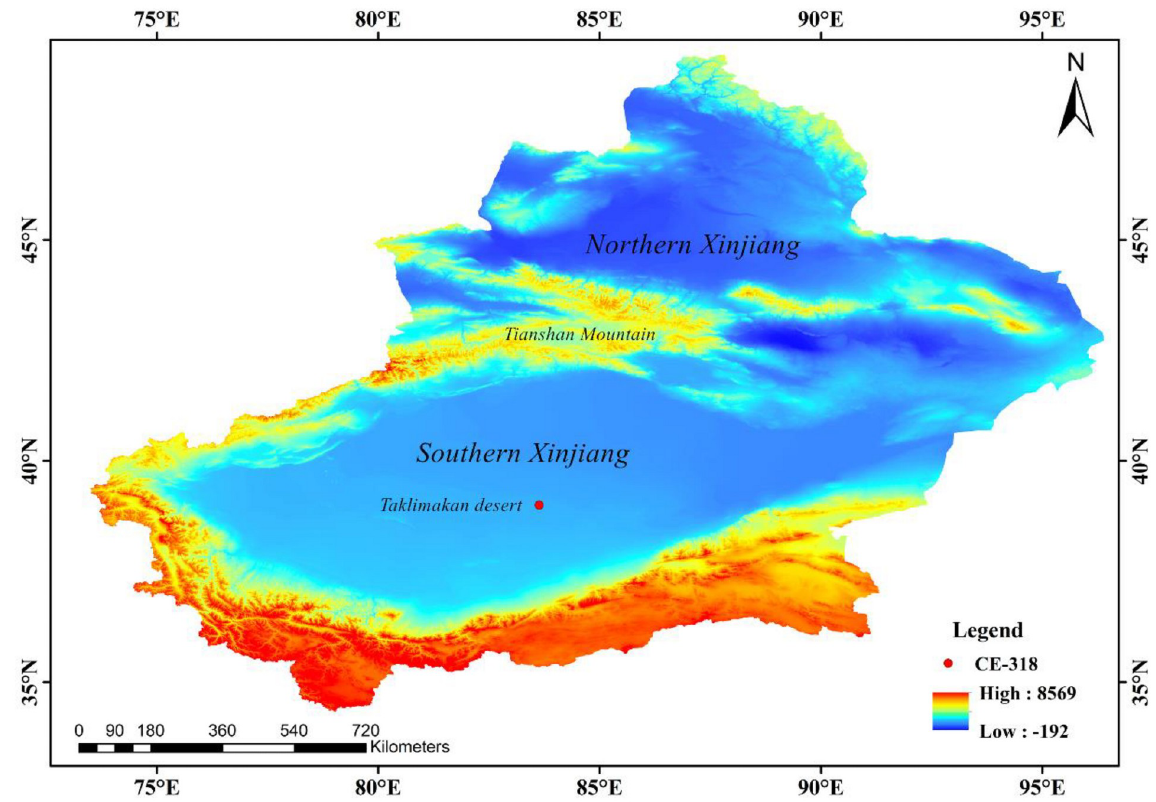
Fig 1. Location of study area (The red is the highest value and dark blue represents the lowest value. Map is created using ArcGIS version 10.3. Xinjiang Uygur Autonomous Region is downloaded from The Gateway to Astronaut Photography of Earth website (https://eol.jsc.nasa. gov/SearchPhotos/) Map credit: Jinglong